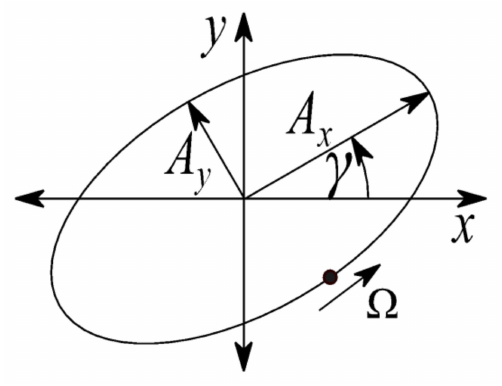
Figure 6. Elliptic